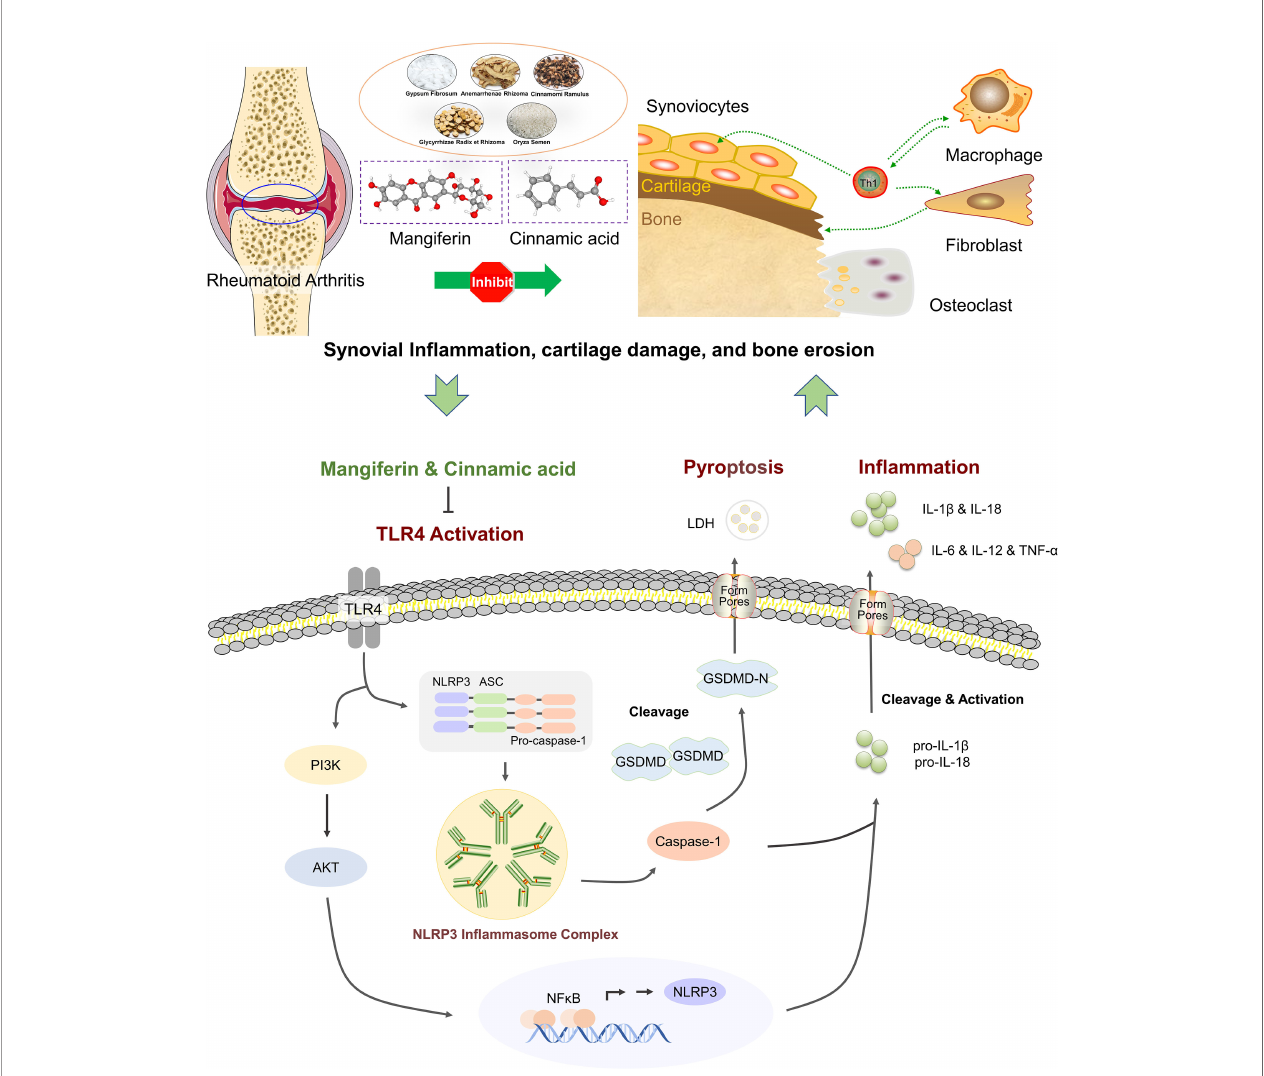
FIGURE 7 | The schematic diagram of the underlying mechanisms of the two-BAC combination of mangiferin (MG) and (CA) against active RA via reversing the imbalance of the “ immune-in fl ammation ” system by inhibiting TLR4/NF k B/NLRP3 activation-induced pyroptosis. “ ⟂ “ : Inhibition. “ ! “ :